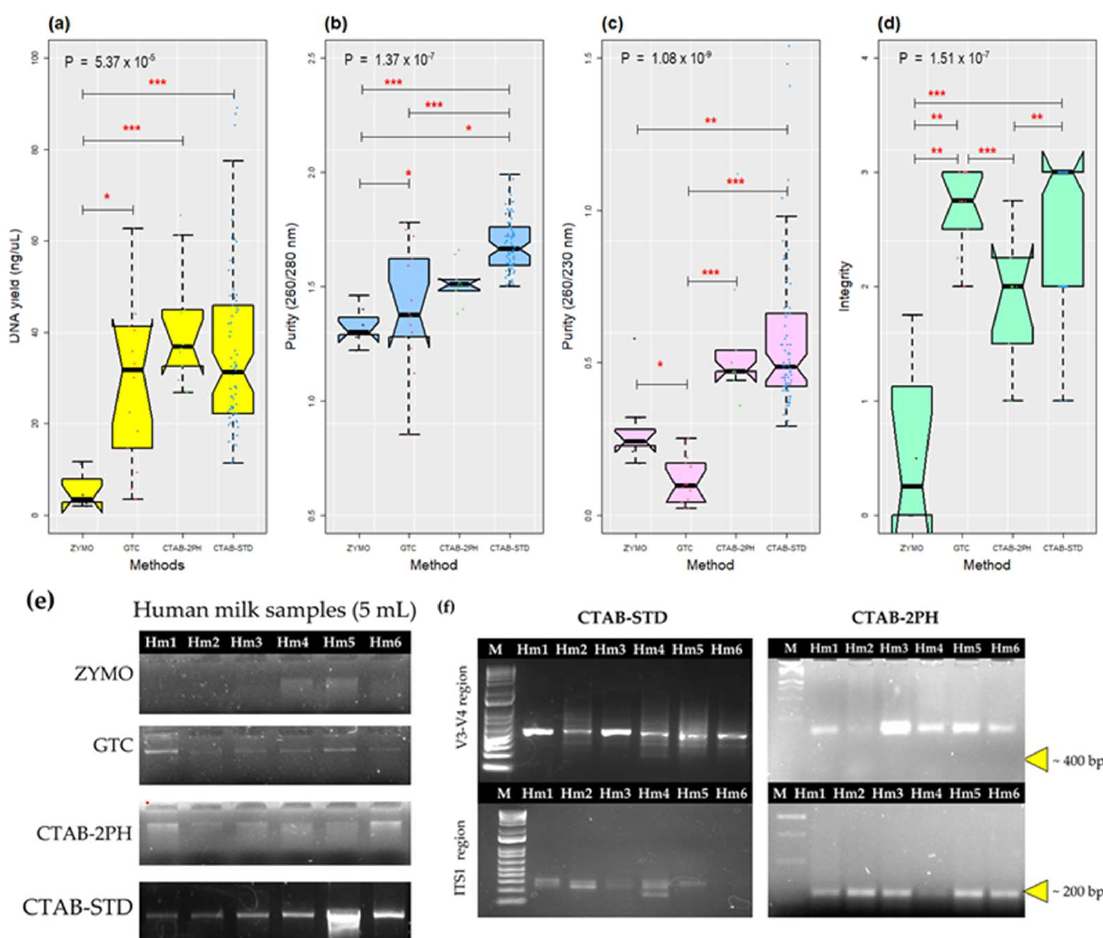
Figure 1. DNA quantity and quality assessment of HM samples. ( a ) Box plot showing the DNA concentration (ng/ µ L). ( b ) Box plot showing the DNA purity at 260/280 nm. ( c ) Box plot showing the DNA purity at 260/230 nm. ( d ) Box plot showing the DNA integrity. ( e ) Representative results from agarose gel electrophoresis analysis of gDNA from HM samples extracted by four different methods. ( f ) Representative results from agarose gel electrophoresis analysis of PCR amplification (V3–V4 and ITS1 regions from 16S and 18S rRNA, respectively) from Hm samples extracted with CTAB-STD and CTAB-2PH. M represents a gene ruler DNA ladder (1 Kb plus from Invitrogen™, MA, USA). The box signifies the 75% (upper) and 25% (lower) quartiles showing the distribution of 50% of the samples. The line inside the box plot represents the median. The whiskers (top and bottom) represent the maximum and minimum values. Outliers, which are beyond 1.5 times the interquartile range above the maximum value and below the minimum value, are shown with the corresponding color dot. p -values for differences between the four methods were calculated using the Kruskal–Wallis statistic. When the difference between methods was significant ( p < 0.05), all pairwise comparisons were tested for significance using the Mann–Whitney–Wilcox procedure with Bonferroni significance correction. *** represents significance when p < 0.001, ** p < 0.01 and * p < 0.05.